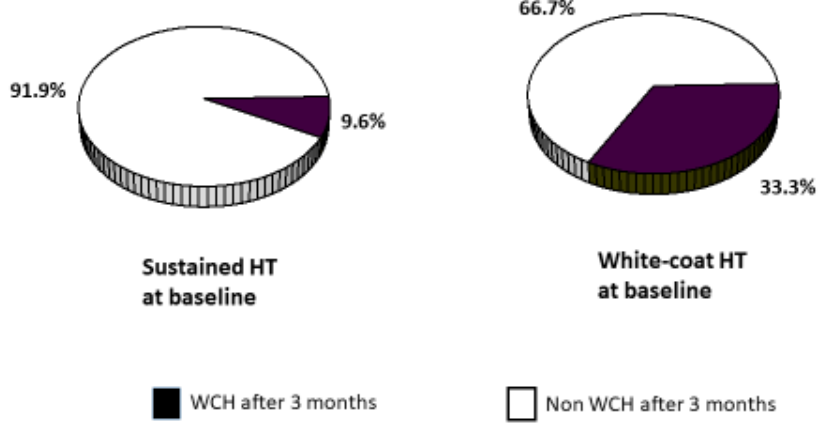
Figure 1. Frequency of white-coat hypertension at second blood pressure assessment performed three months after enrolment, in the participants stratified according to whether they had WCH or sustained hypertension at baseline. HT indicates hypertension; WCH indicates white-coat hypertension.